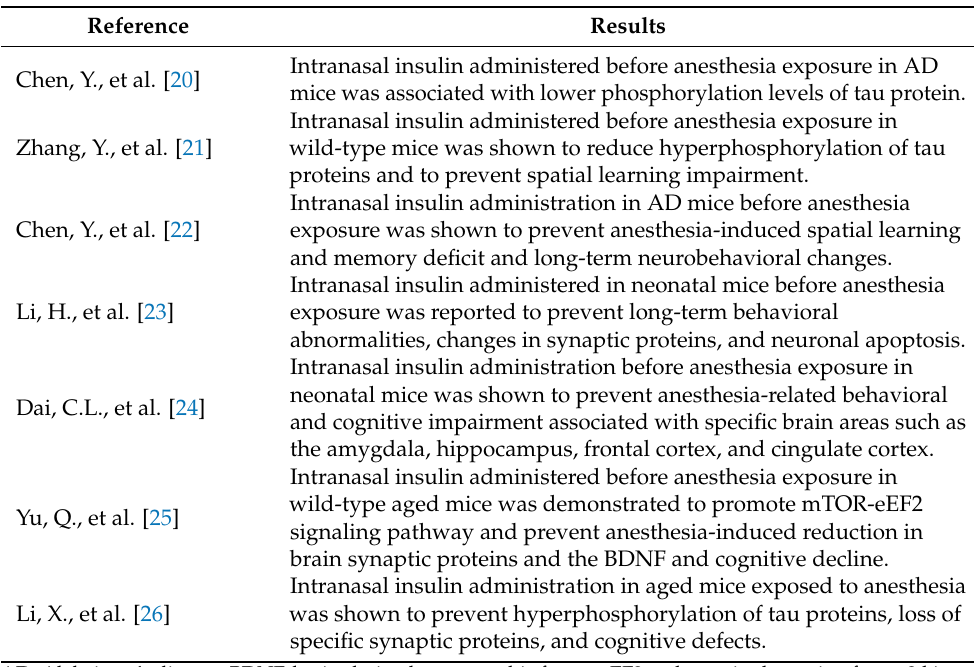
Table 1. Preclinical evidence: intranasal insulin for preventing changes in the brain molecular pattern and/or neurobehavioral after anesthesia exposure in animal